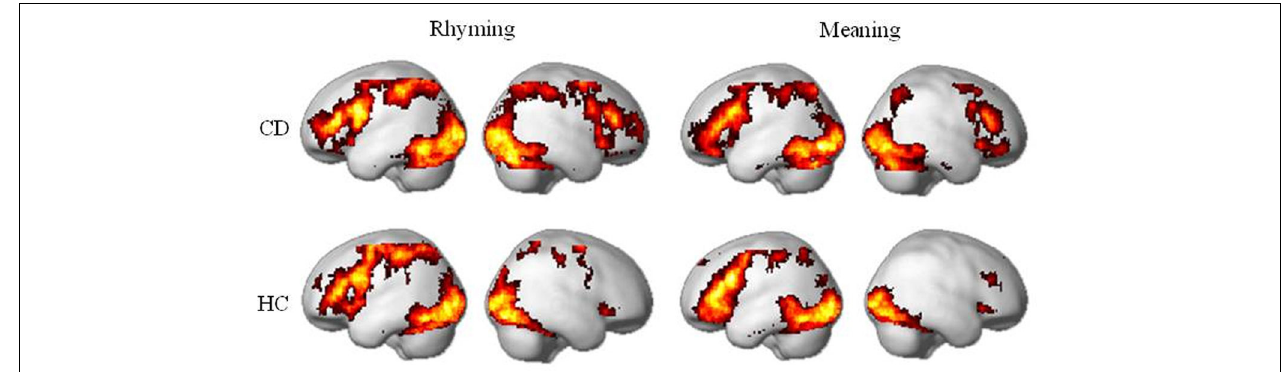
FIGURE 1 | Brain activity within congentially deaf individuals (CD) and hearing controls (HC) in the rhyming task and the meaning task. For both tasks, congenitally deaf individuals show similar activity to the hearing controls in the left hemisphere, but